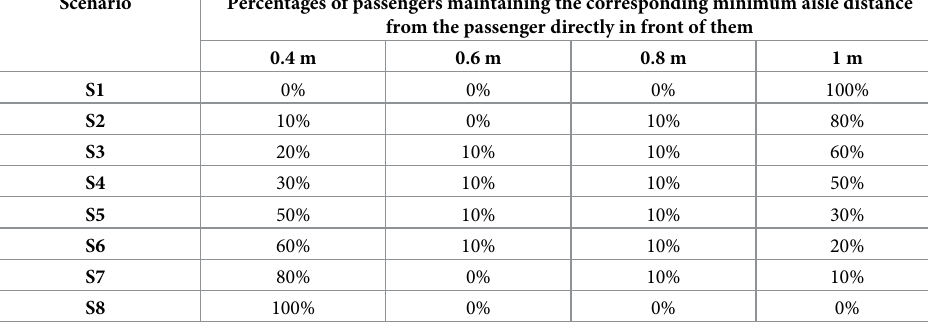
Table 1. Passengers compliance